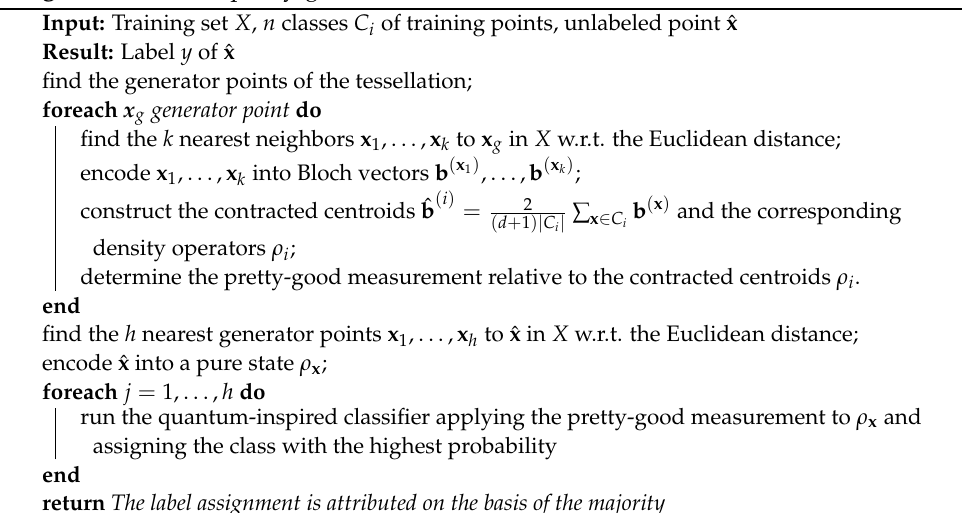
Algorithm 1: Local pretty-good classifier